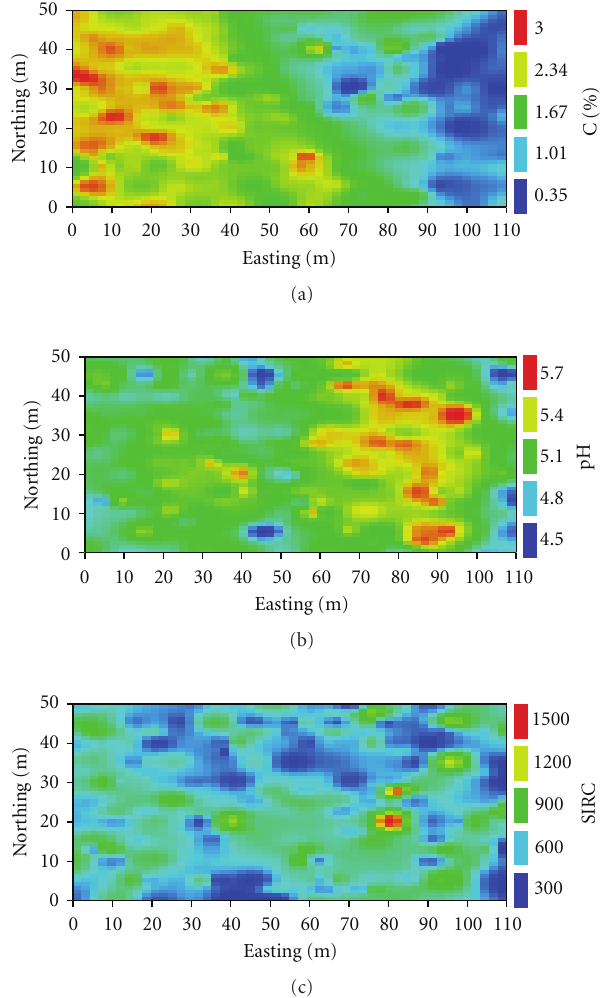
Figure 2: Interpolated spatial maps, over the 110 by 50 m field, of %C, pH and microbial biomass C (SIRC). Units are the same as Table